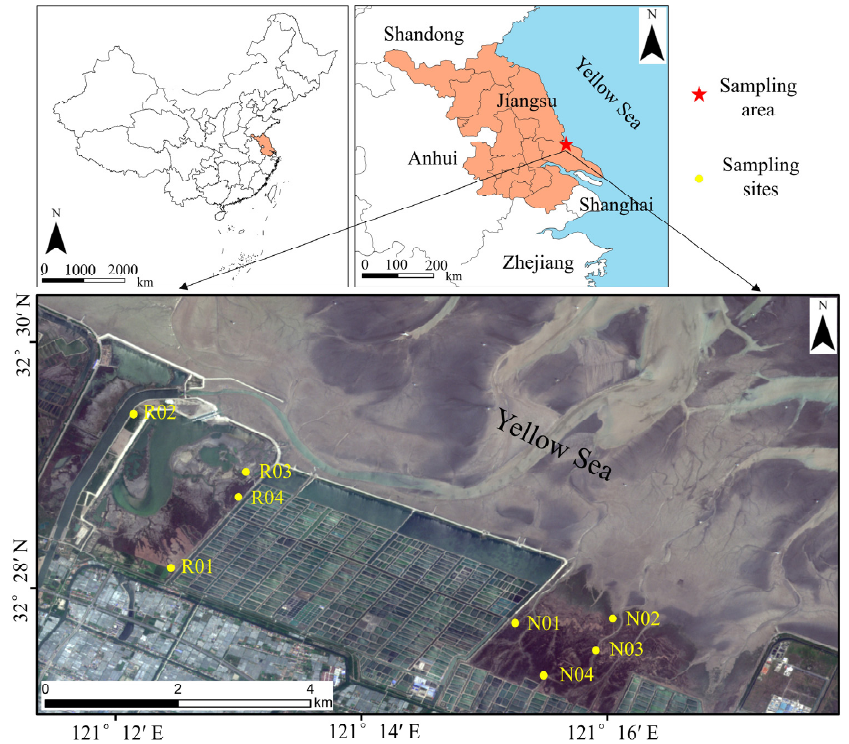
Figure 1. Maps detailing the study area location and the sampling sites.